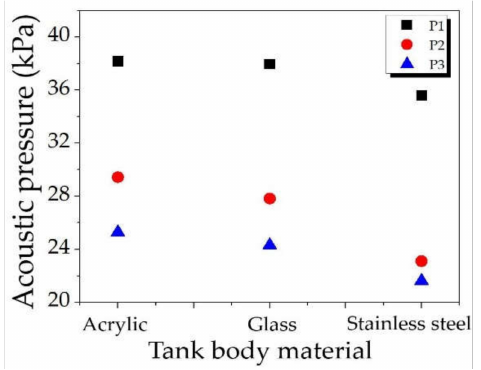
Figure 11. The acoustic pressures for varying positions and tank body materials.